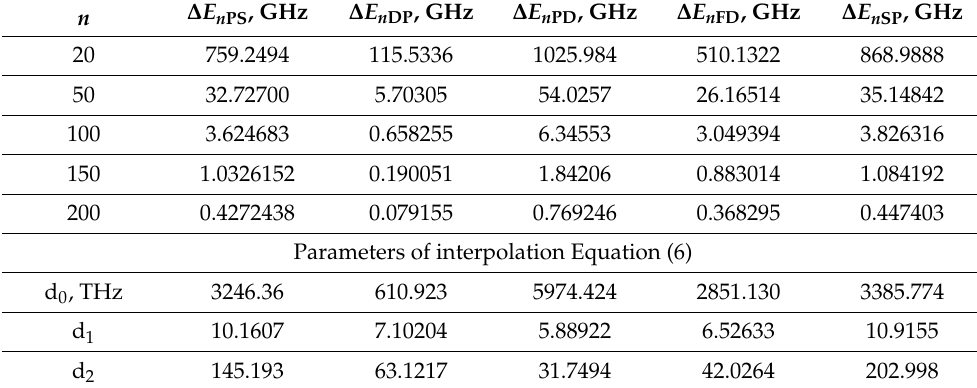
∆ E = E − E ( n + 1 ) P 3/2 ; from n DP n D 5/2 − E − 2)F n D 5/2 ; from state ( n 7/2 to state n D 5/2 , 3/2